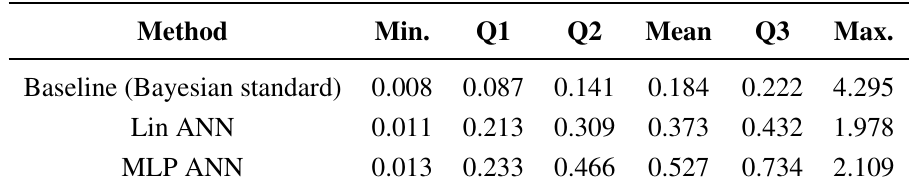
Table 2. Comparison between Bayesian baseline and ANNs models. Both methods has a p = 8 inputs and q = 8